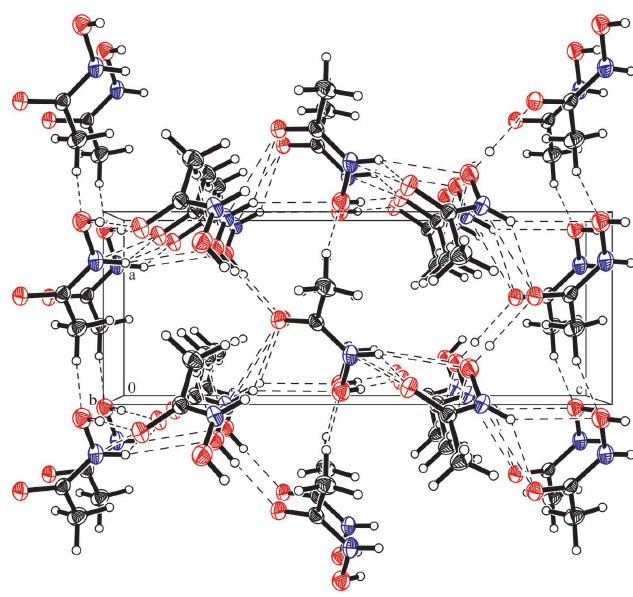
Figure 2 The crystal packing of the title compound, viewed along the b axis.